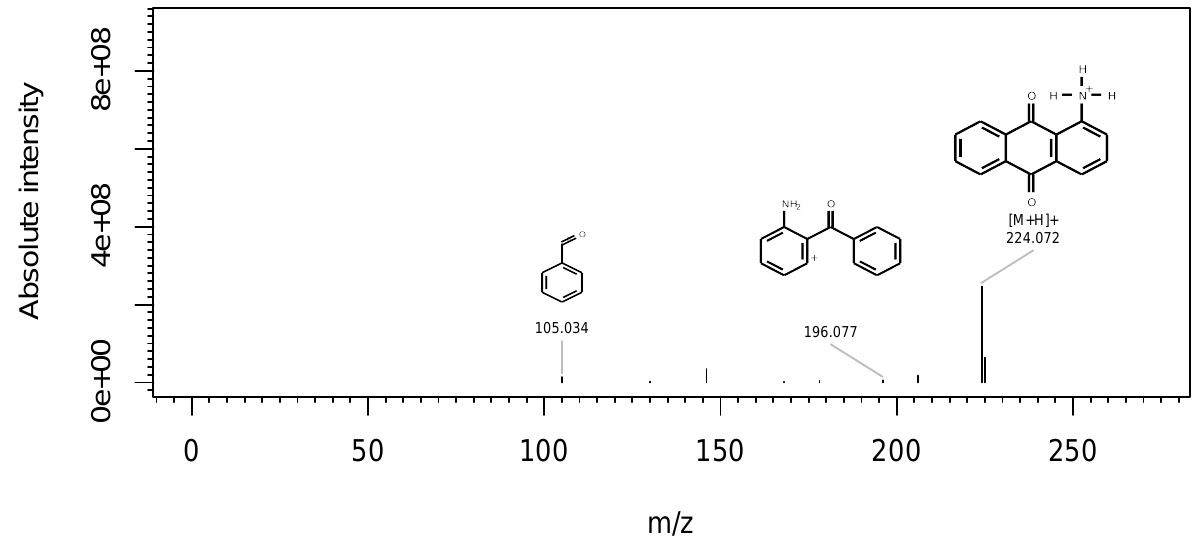
Figure A8. Challenge 11: annotated merged MS and MS/MS spectra of 1-pyrenemethanol (APCI, positive